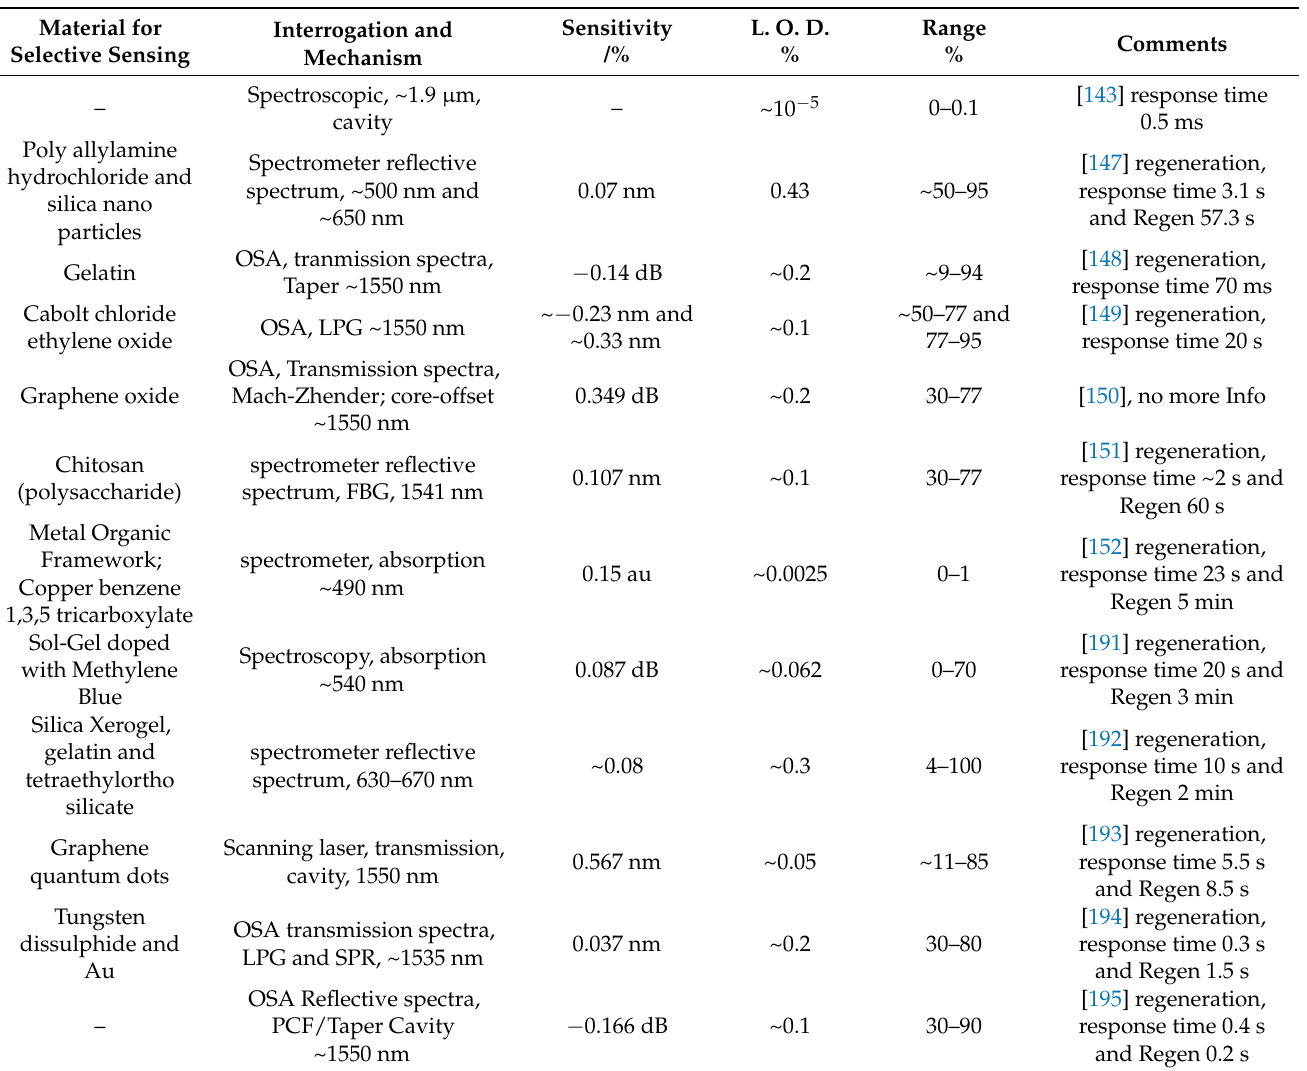
Table 4. Summary of various optical fibre sensors for the detection of water